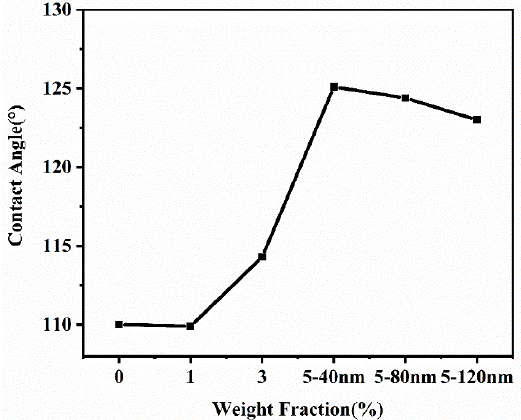
Figure 8. Hydrophobic angle of blend film with different PS mass fraction.